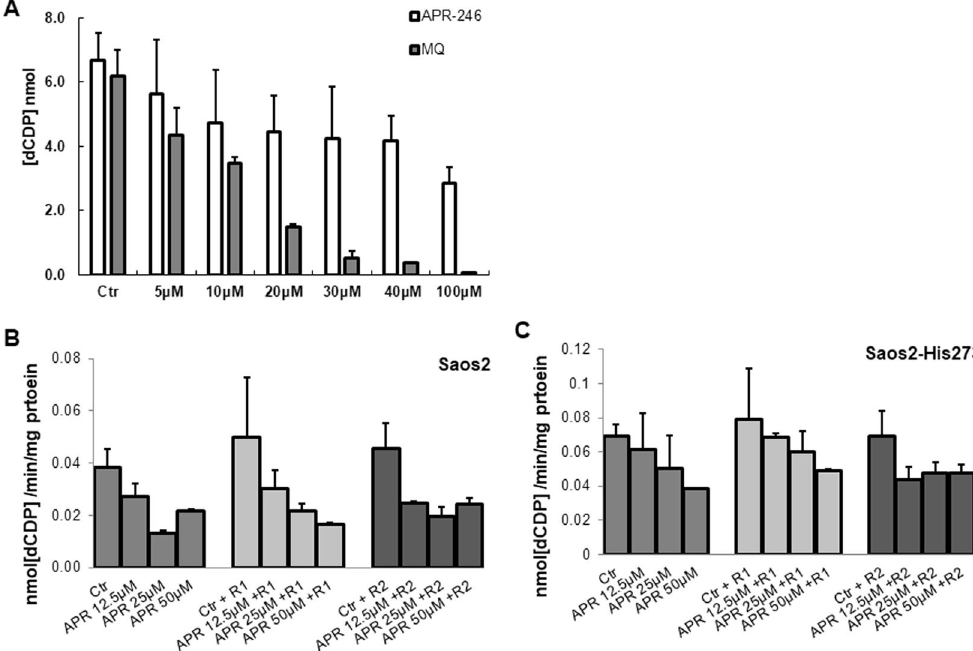
Figure 6. Effect of APR-246 and MQ on RNR activity. ( A ) Effects of APR-246 and MQ on RNR activity in vitro using recombinant R1 and R2 proteins. ( B ) RNR activity in Saos-2 cells treated with 12.5, 25 and 50 µ M of APR- 246 for 24 hours with addition of excess recombinant R1 and R2. ( C ) RNR activity in Saos-2-His273 cells treated with 12.5, 25 and 50 µ M of APR-246 for 24 hours with addition of excess recombinant R1 and